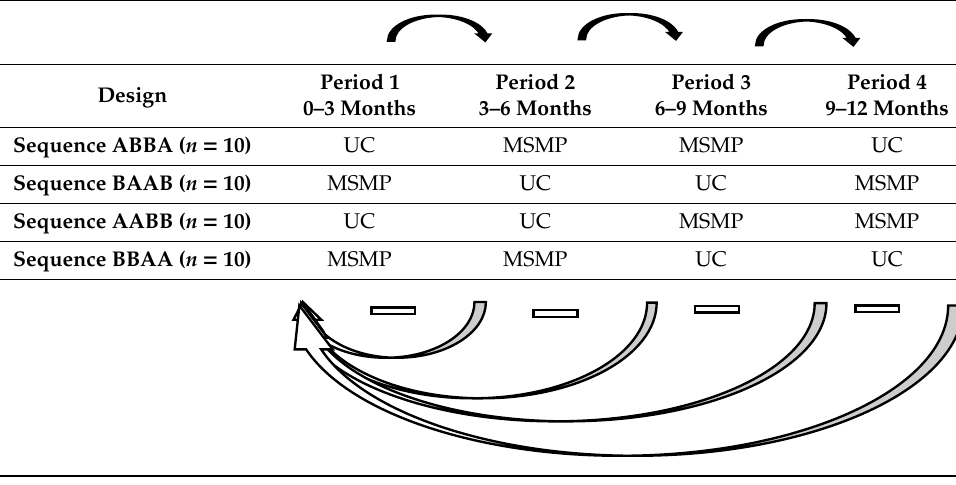
Table 1. Crossover plan of participants enrolled in the